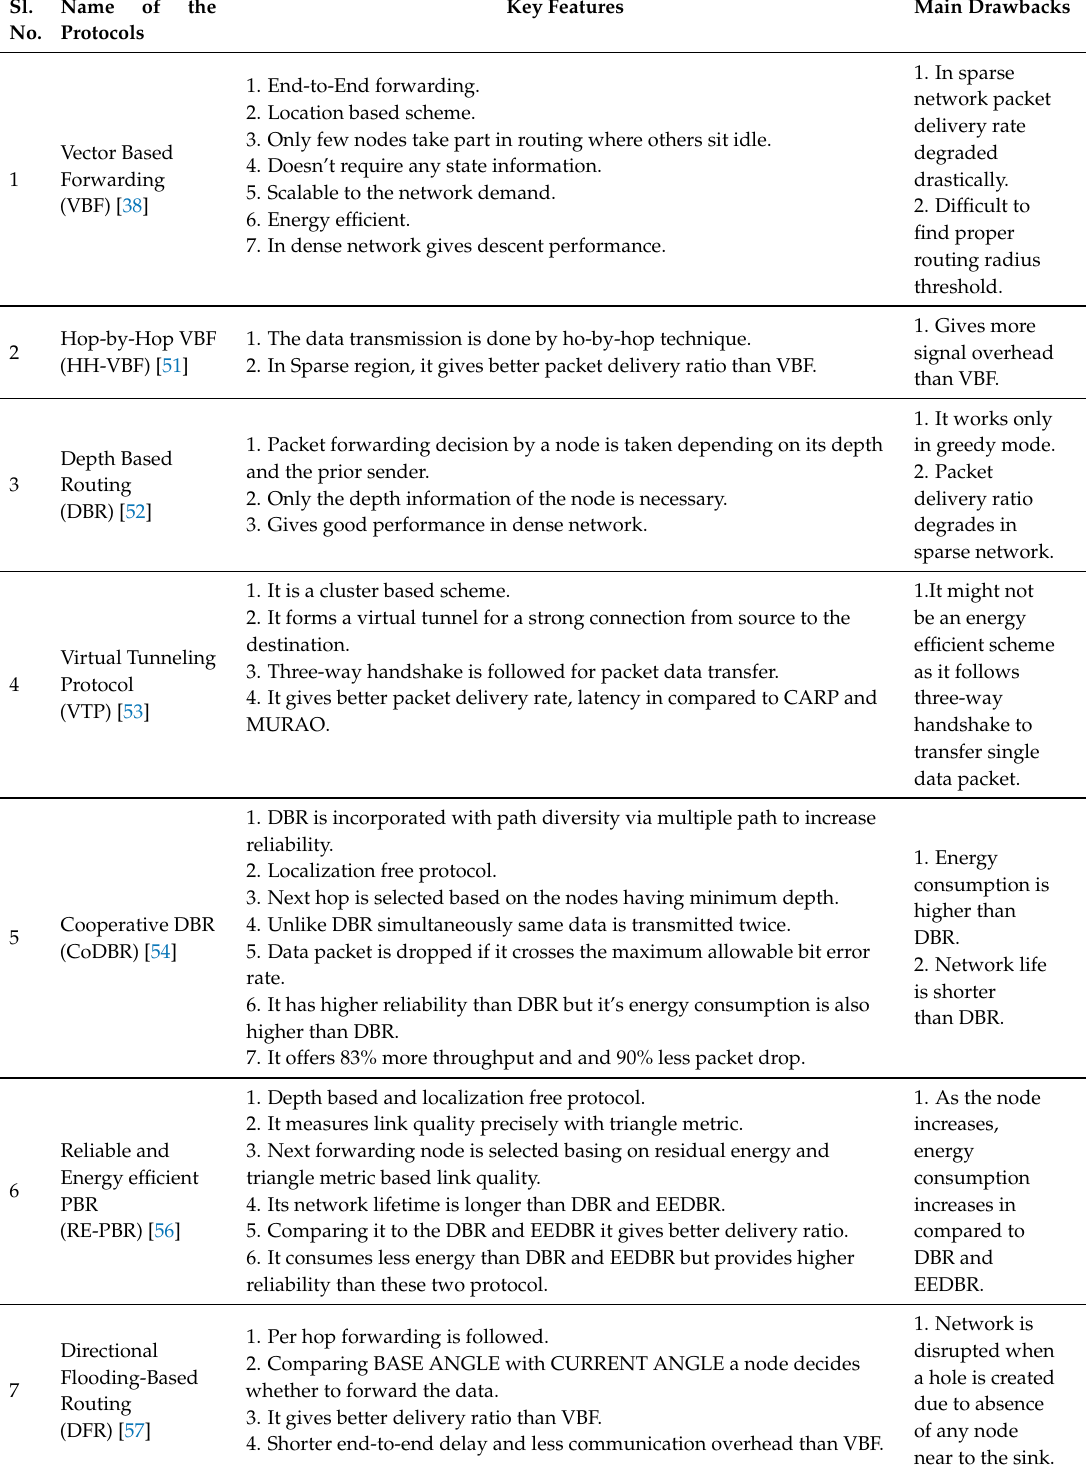
Table 3. Key features and main drawbacks of different routing